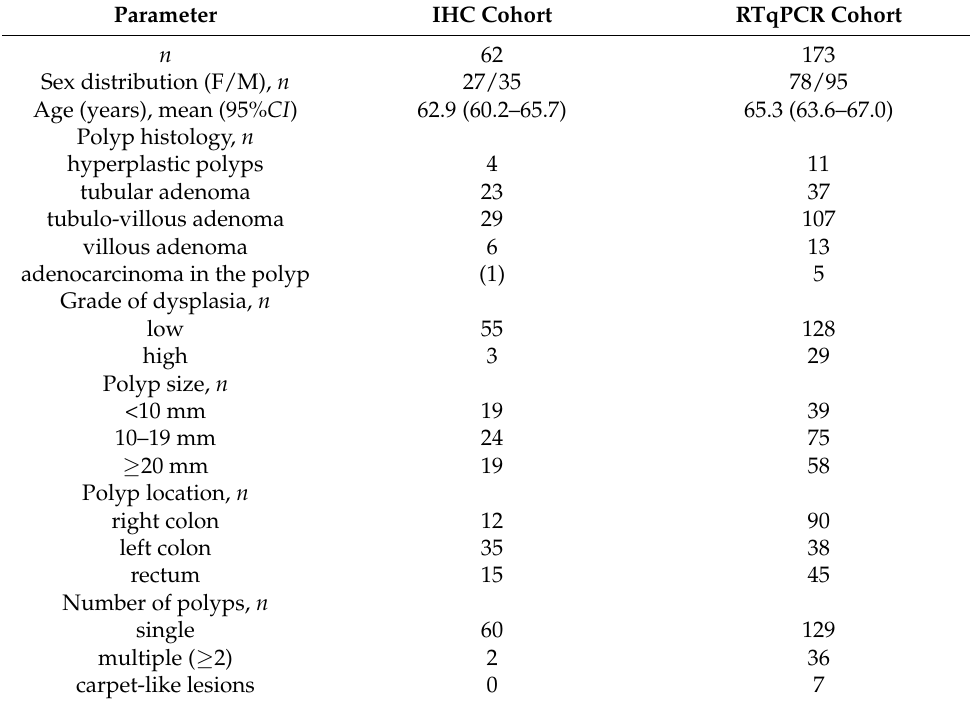
Table 1. Characteristics of patients with colorectal